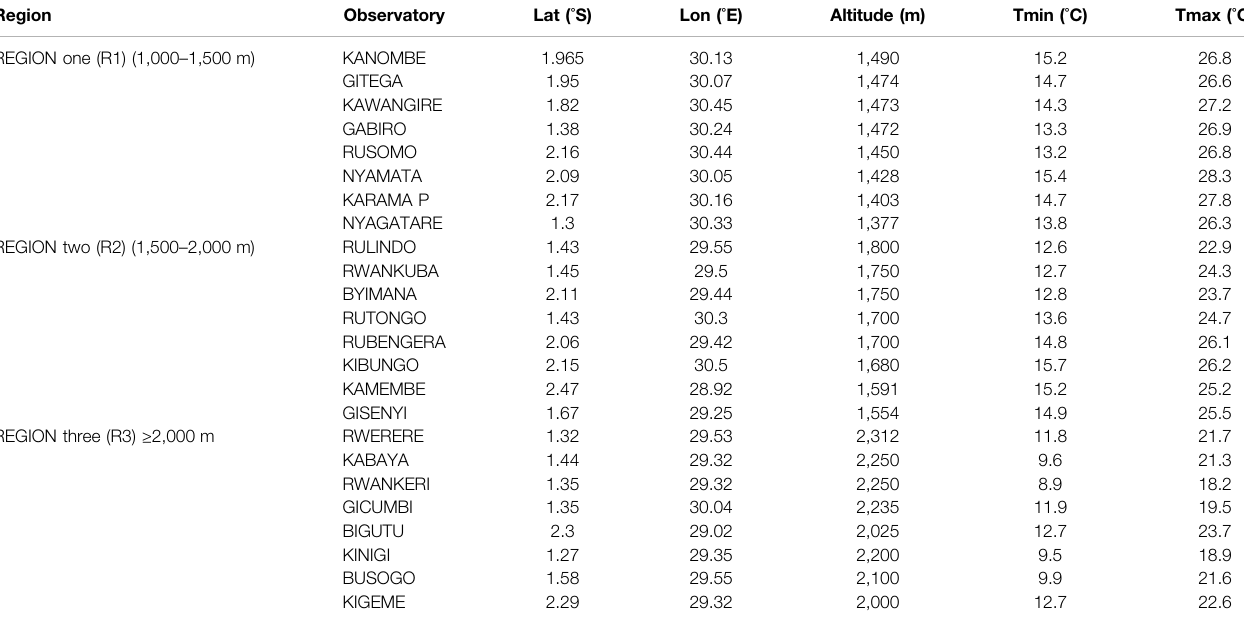
TABLE 1 | Selected Stations and their respective location based on their elevation in three various regions (region one, region two and region three). Region Observatory Lat ( ° S) Lon ( ° E) REGION one (R1) (1,000 – 1,500